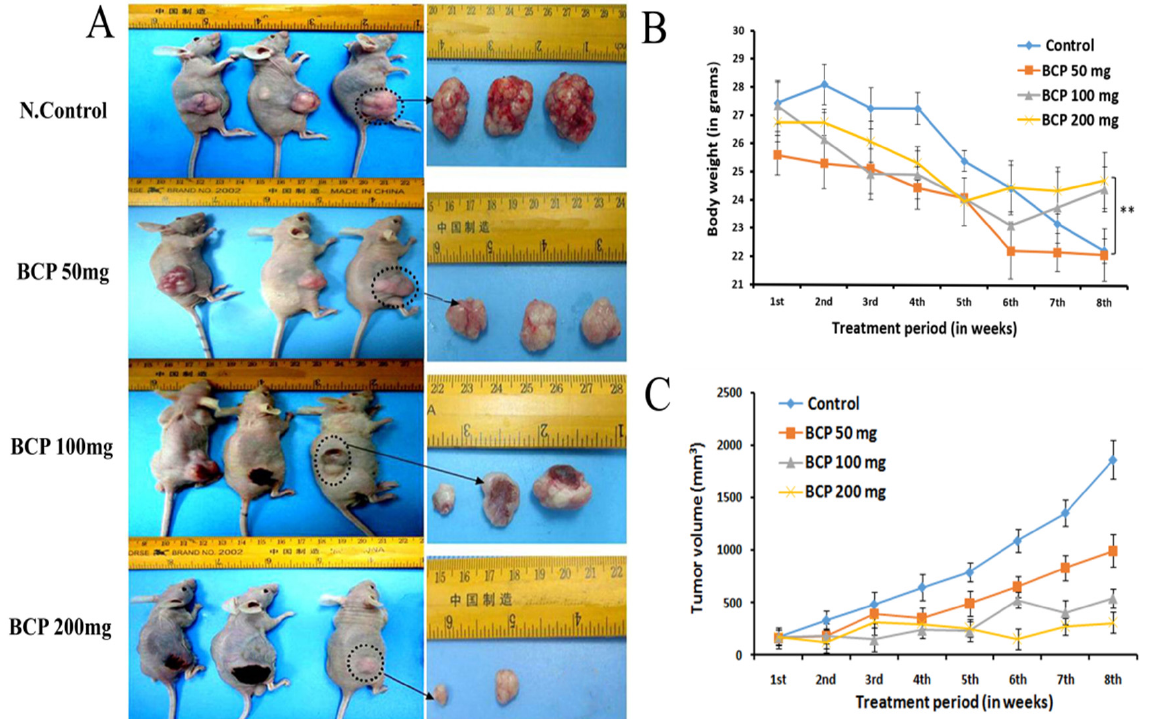
Figure 5. BCP inhibited tumor growth in an ectopic tumor model. Photographic images represent a subcutaneous xenograft mice model with regard to tumor growth and tumor sizes. Mice were injected subcutaneously with HCT 116 cells 8 days before treatment. Different doses of BCP were supplemented for 8 weeks and the tumor size was measured ( A ). The dose-response relationship of BCP on the body weight of vehicle-treated (control) and BCP-treated animals ( B ). ** p < 0.01 compared to control group. The dose-response relationship of BCP on tumor size of vehicle-treated (control) and BCP-treated animals. Each point represented the mean ± SD of 6 tumors ( C ).